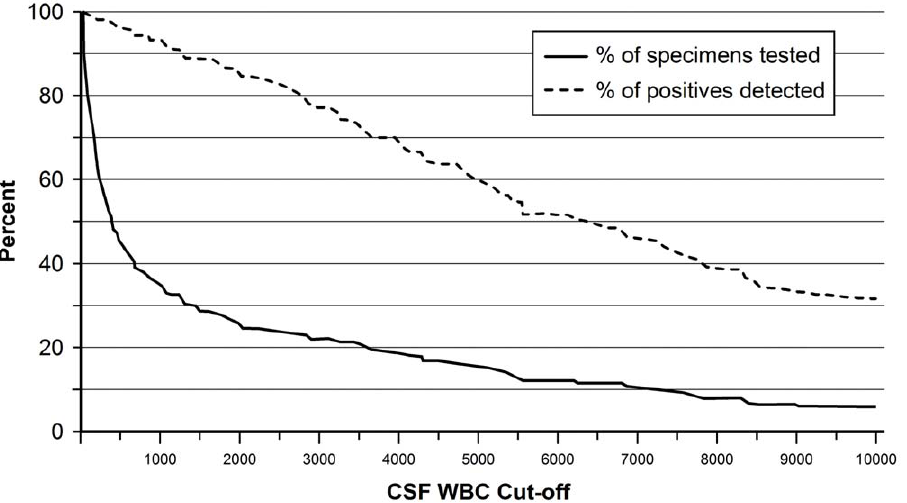
Figure 3. Relationship between minimum CSF WBC count used as a cut-off to determine what specimens are tested by RT-PCR and 1) the proportion of the total RT-PCR positives (n=122) that are identified (dashed line) and 2) the proportion of all specimens (n=481) that would be tested (solid line). For example, if only those specimens with a CSF WBC of at least 1000 had been tested, about 34% of the 481 CSF specimens would have been tested, which would have detected about 92% of the 122 specimens that were RT-PCR positive. Data were censored at a CSF WBC cut-off of 10,000. Data are for culture-negative and culture unknown specimens. Includes 188 patients with unknown culture results.